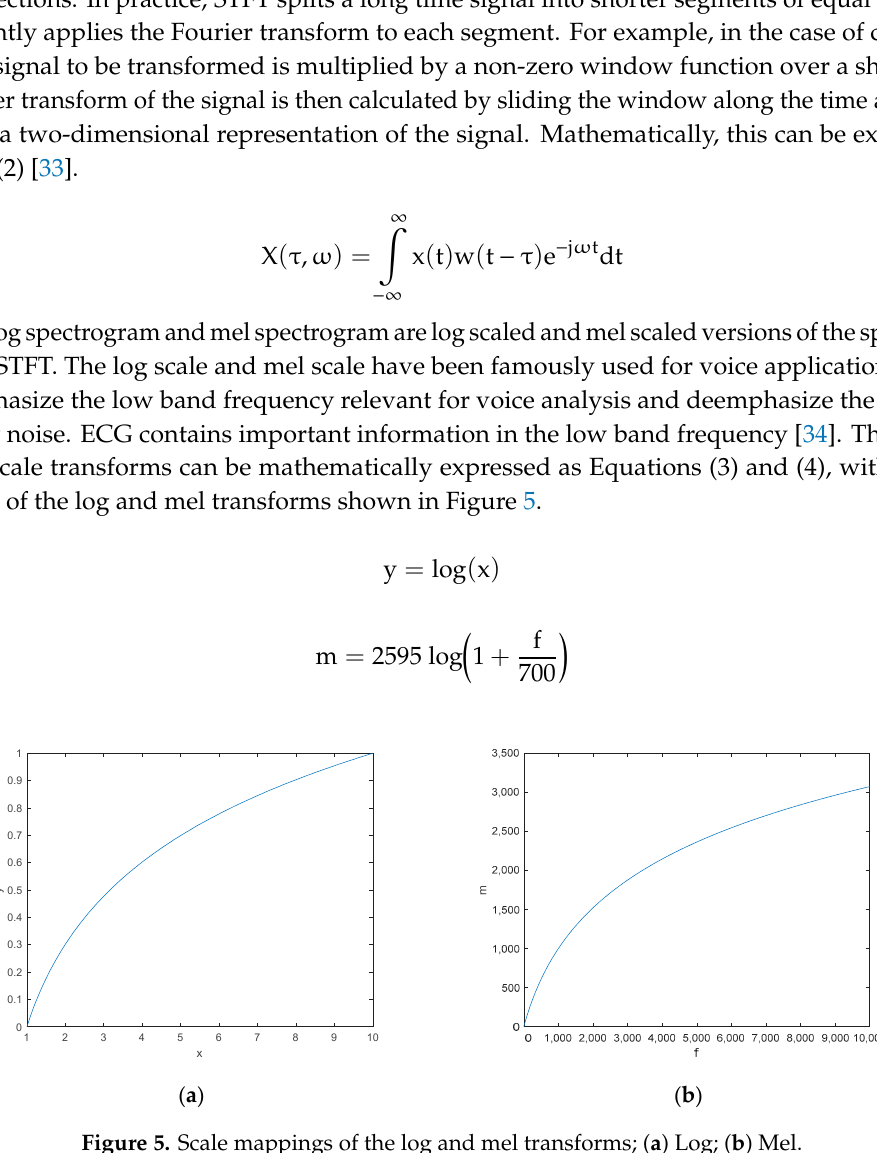
Figure 6. Process used to calculate MFCC.